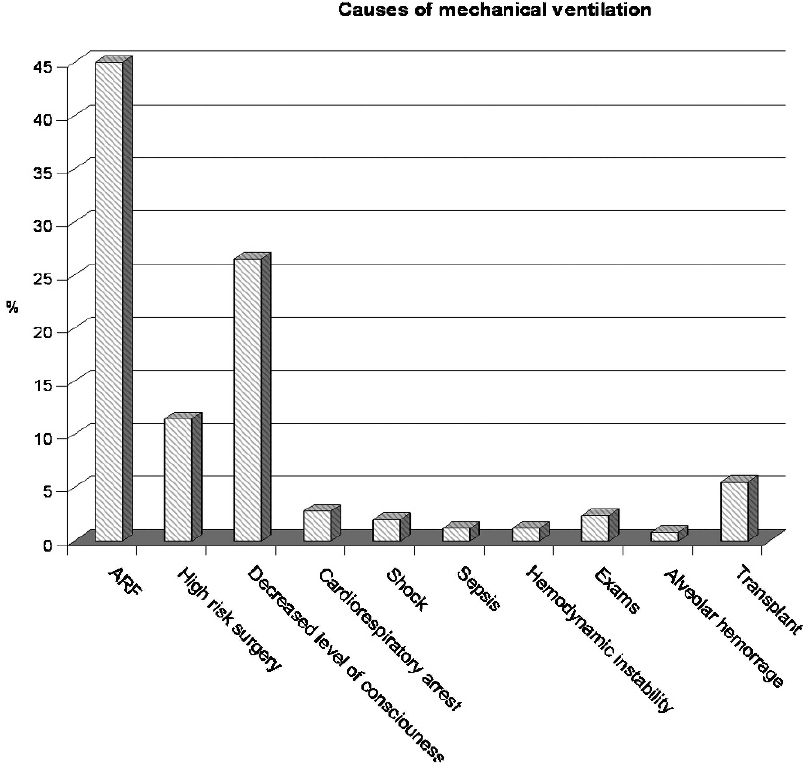
Figure 1 - Causes of orotracheal intubation for 252 mechanically ventilated patients. ARF: acute respiratory